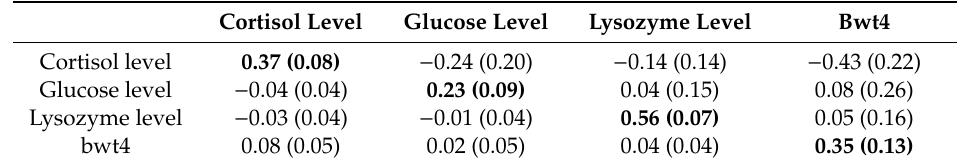
Table 2. Estimates of heritability (bold), genetic correlation, and phenotypic correlation (above and below the diagonal, respectively). Standard errors are in parenthesis.